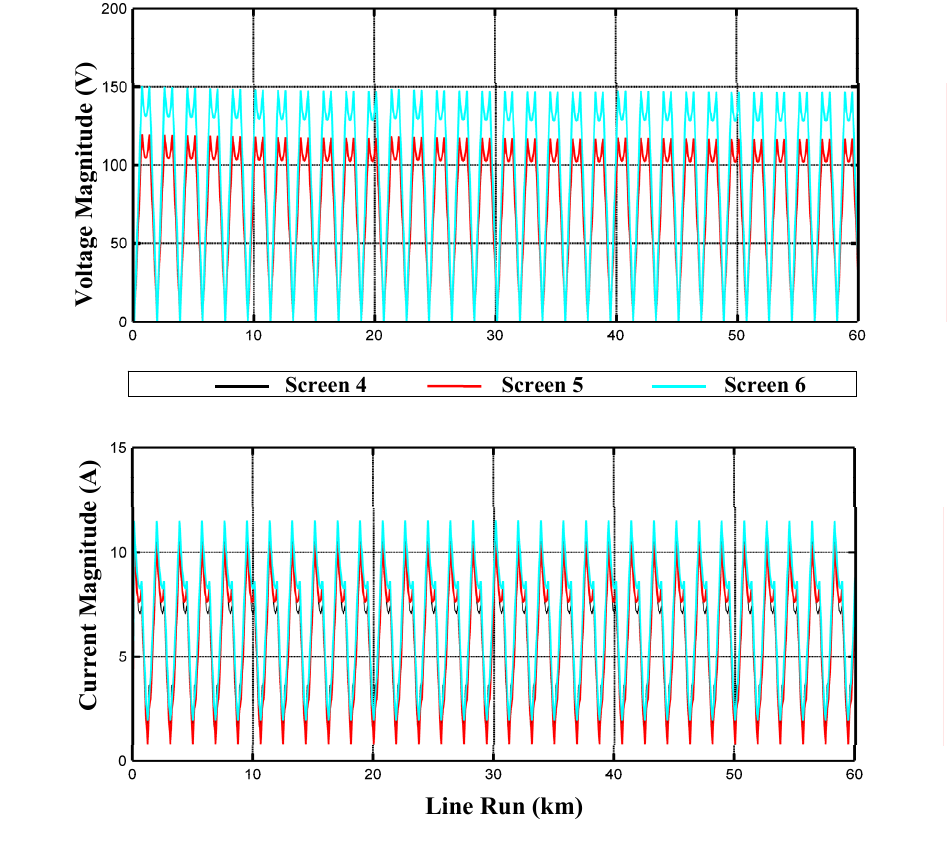
Figure 11. Screen voltage and current magnitudes along the compensated single-circuit cable in CB with